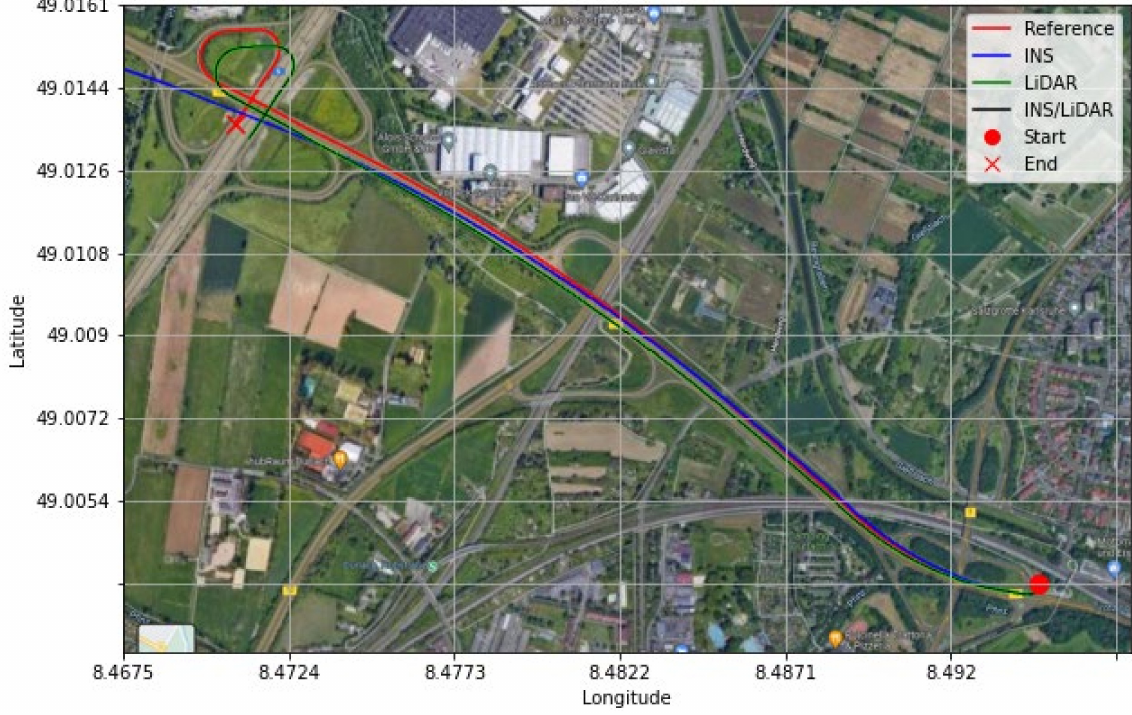
Figure 18. D-42—complete GNNS signal outage: comparison of